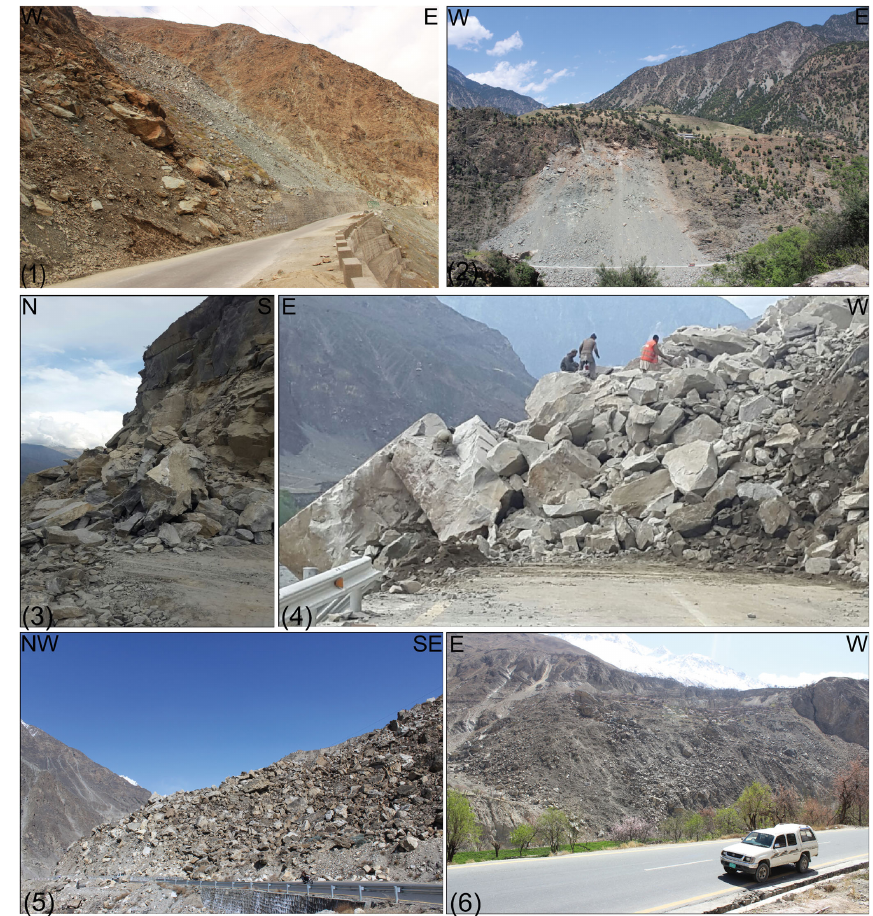
Figure 11. Example of landslide events (Ali et al., 2017) (locations of the photos are given in Figs. 9 and 10).